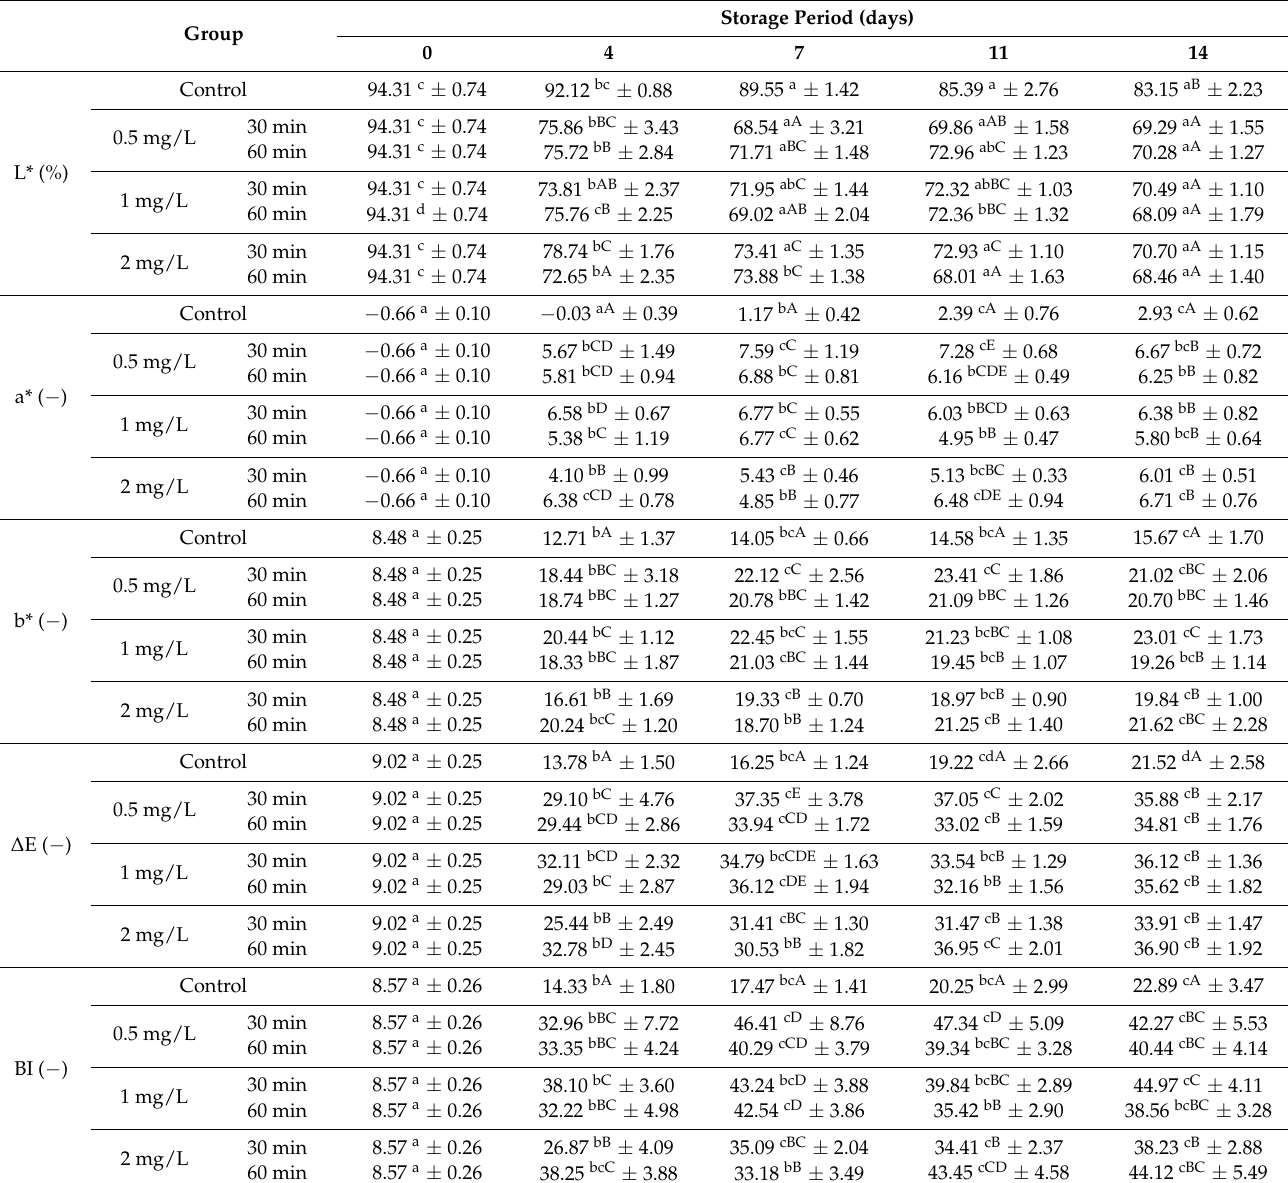
Table 3. Effect of ozone dose, time of ozonization, and storage time on the external color parameters of the Agaricus bisporus measured at 0, 4, 7, 11, and 14 days of